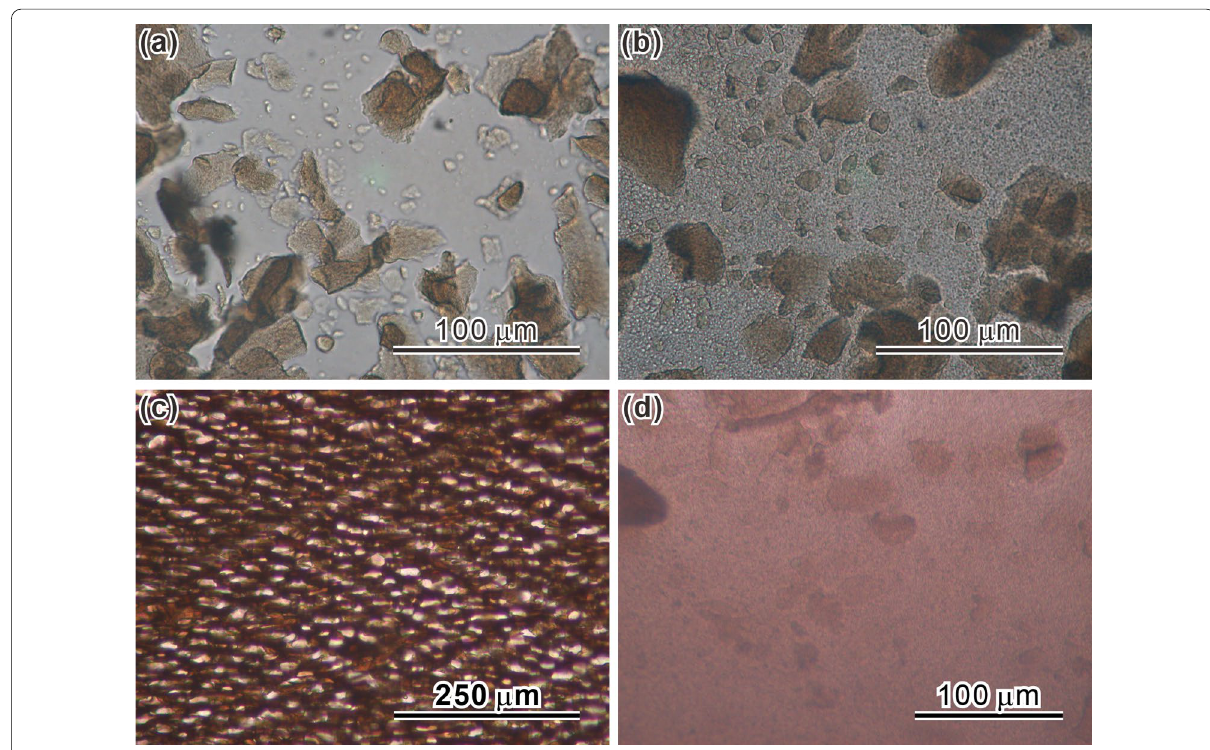
Fig. 3 Optical images of agglomerated secondary grains. a Freeze‑dried powder without CAS conditions under plane‑polarised light (PPL). b Freeze‑dried powder with pure water solvent and CAS conditions (PPL). c Frozen suspension with pure water solvent under CAS conditions (PPL). d Freeze‑dried powder with ethanol as the dissolved solvent and CAS conditions